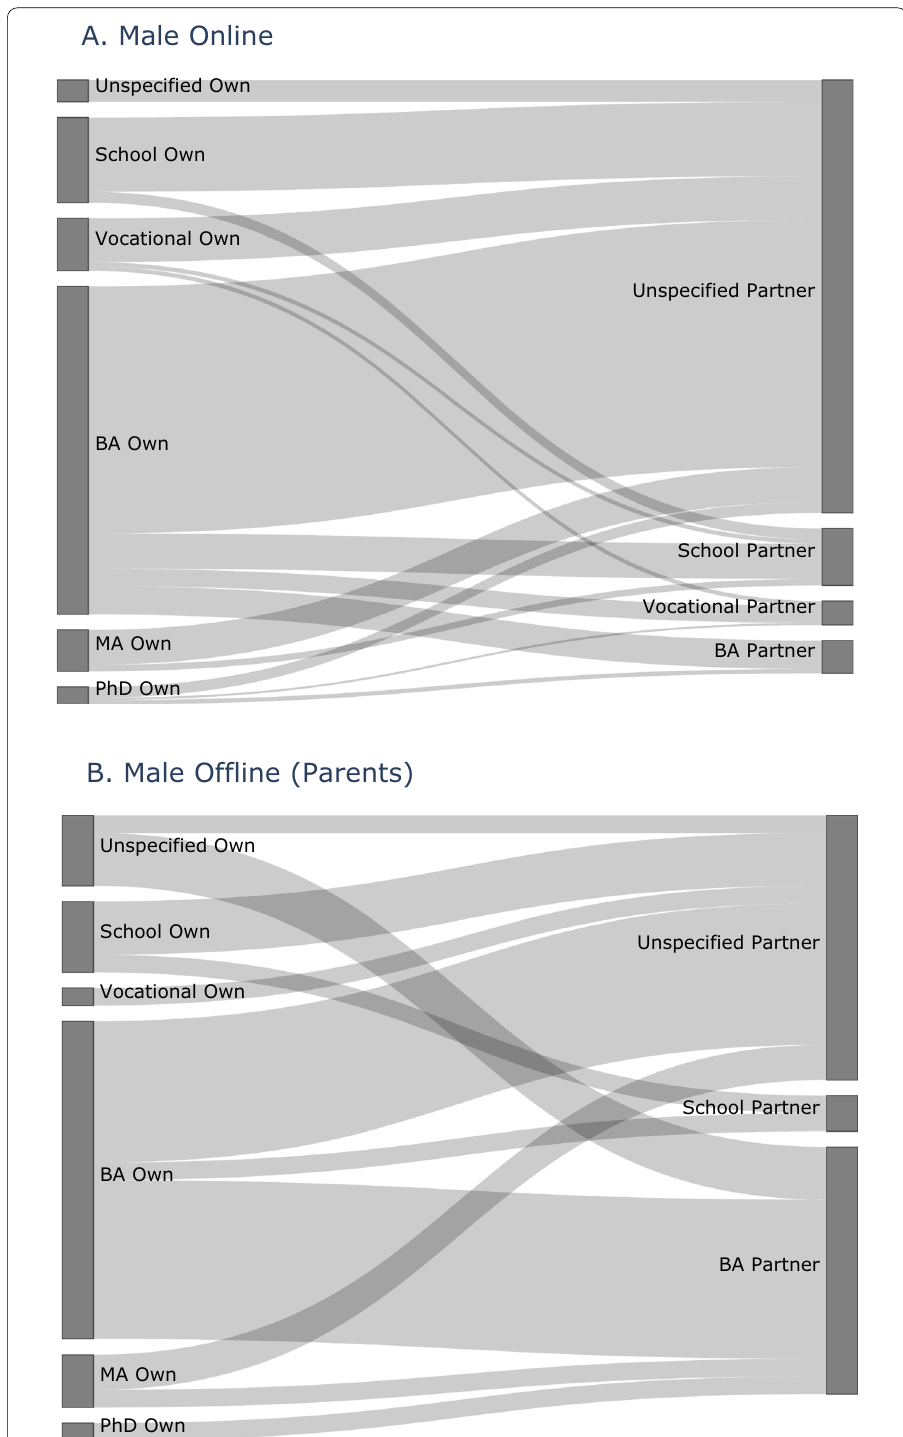
Fig. 4 Flow of male preferences from Own Education to desired Partner Education , including those who did not specify either of these